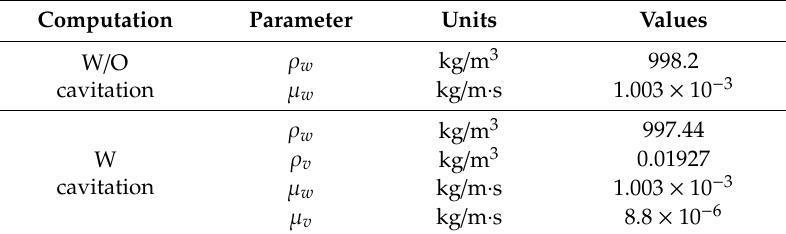
Table 2. Experimental and computational